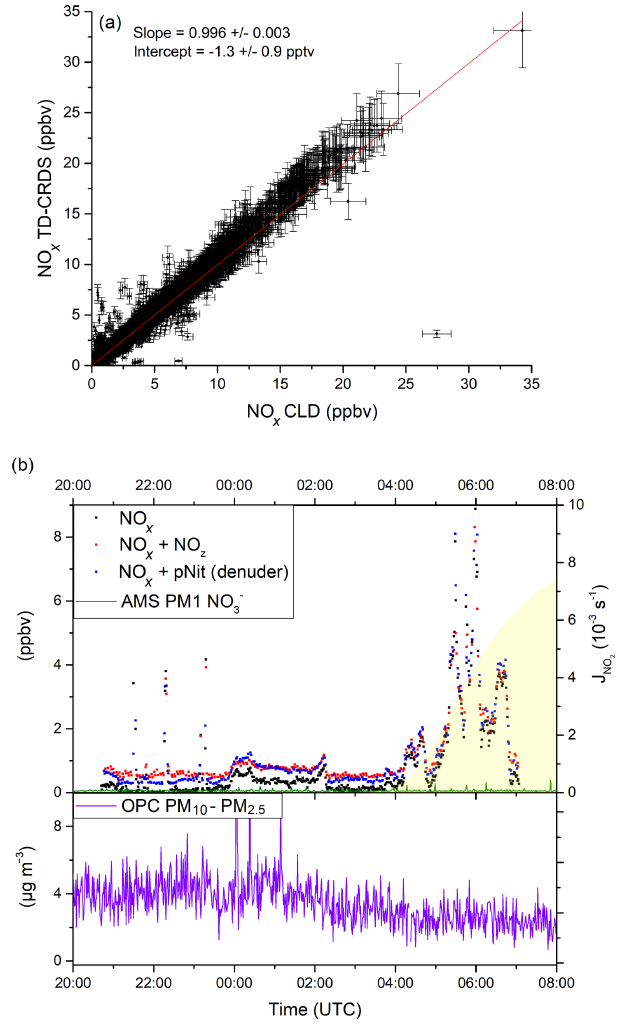
Figure 10. (a) Correlation between the TD-CRDS NO x measure- ments (1min averages) and an independent CLD NO x instrument from the AQABA campaign. Data obtained during phases of very high NO x variability have been excluded (see Sect. 4.1). See Fig. S6 for a histogram of the NO x data points. (b) pNit measurements us- ing the denuder channel (blue data points) during AQABA and com- parison with particulate NO − from an AMS (aerosol mass spec- 3 trometer). The discrepancy towards the AMS and the correlation with the NO x mixing ratios indicate a positive bias in the pNit measurements, caused by humidity effects on the denuder surface. OPC (optical particle counter) measurements are added in the lower panel of (b) in order to assess the potential influence of coarse-mode aerosol